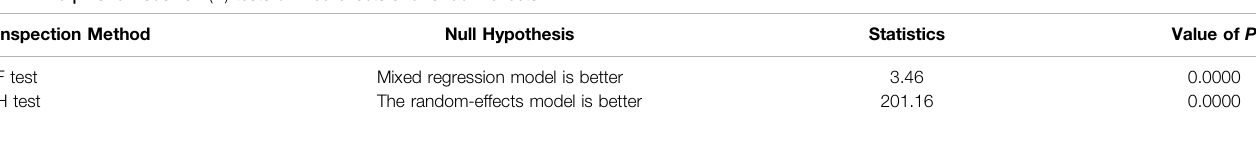
TABLE 3 | F and Hausman (H) tests of fi xed effects and random